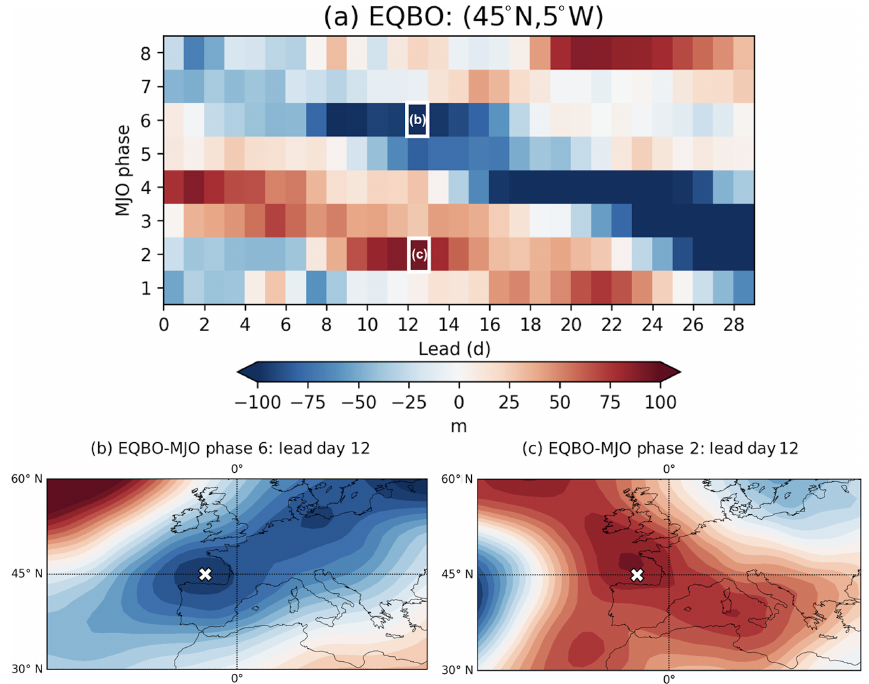
Figure 1. Boreal winter (DJF) composite ERA-I z500 anomalies subsampled to ECMWF initialization dates (1995–2016) for (a) each MJO phase during EQBO vs. lead at 45 ◦ N and 5 ◦ W. White boxes and text denote the corresponding panels below. Panels (b) and (c) include composite ERA-I z500 anomalies subsampled to ECMWF initialization dates (DJF, 1995–2016) over Europe for (b) phase 6 and (c) phase 2 at lead day 12. The white X denotes 45 ◦ N and 5 ◦